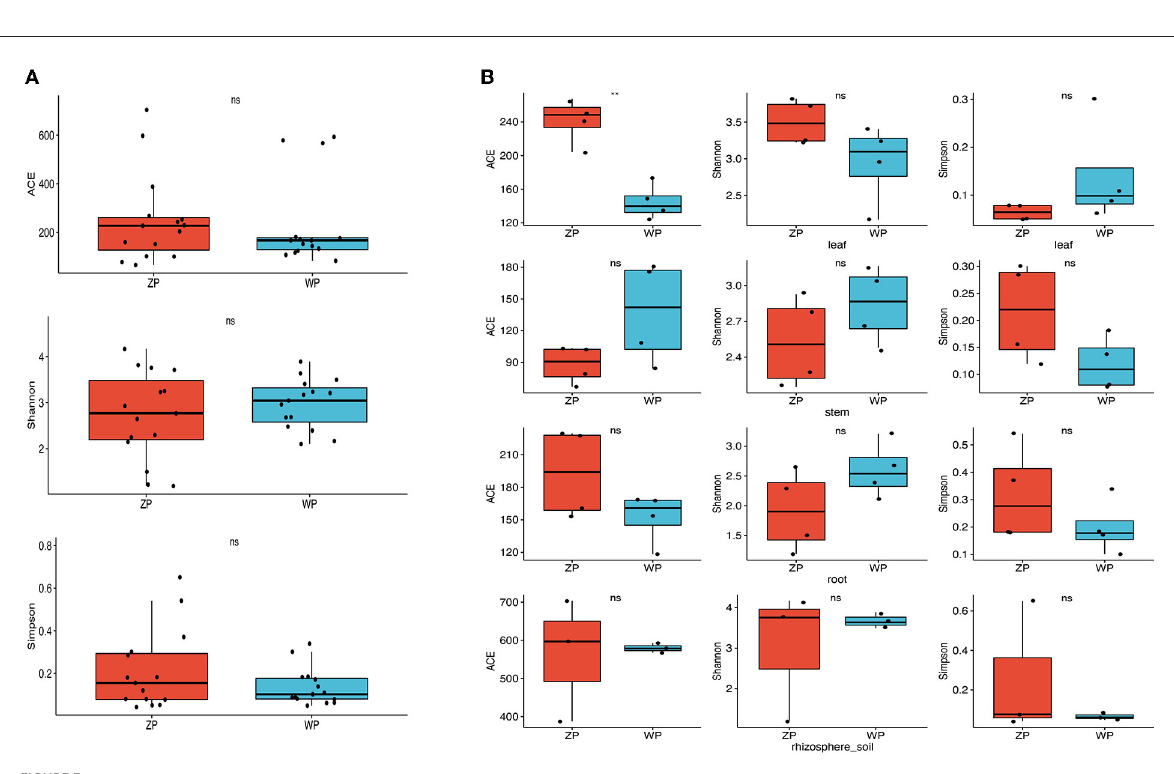
FIGURE3 Alpha diversity of fungal communities; (A) Difference analysis between whole plant of two species; (B) Difference analysis between three compartments of two species. *Means P-value < 0.05, **means P-value < = 0.01, ***means p-value < = 0.001, ****means P-value < = 0.0001, ns mean P-value >